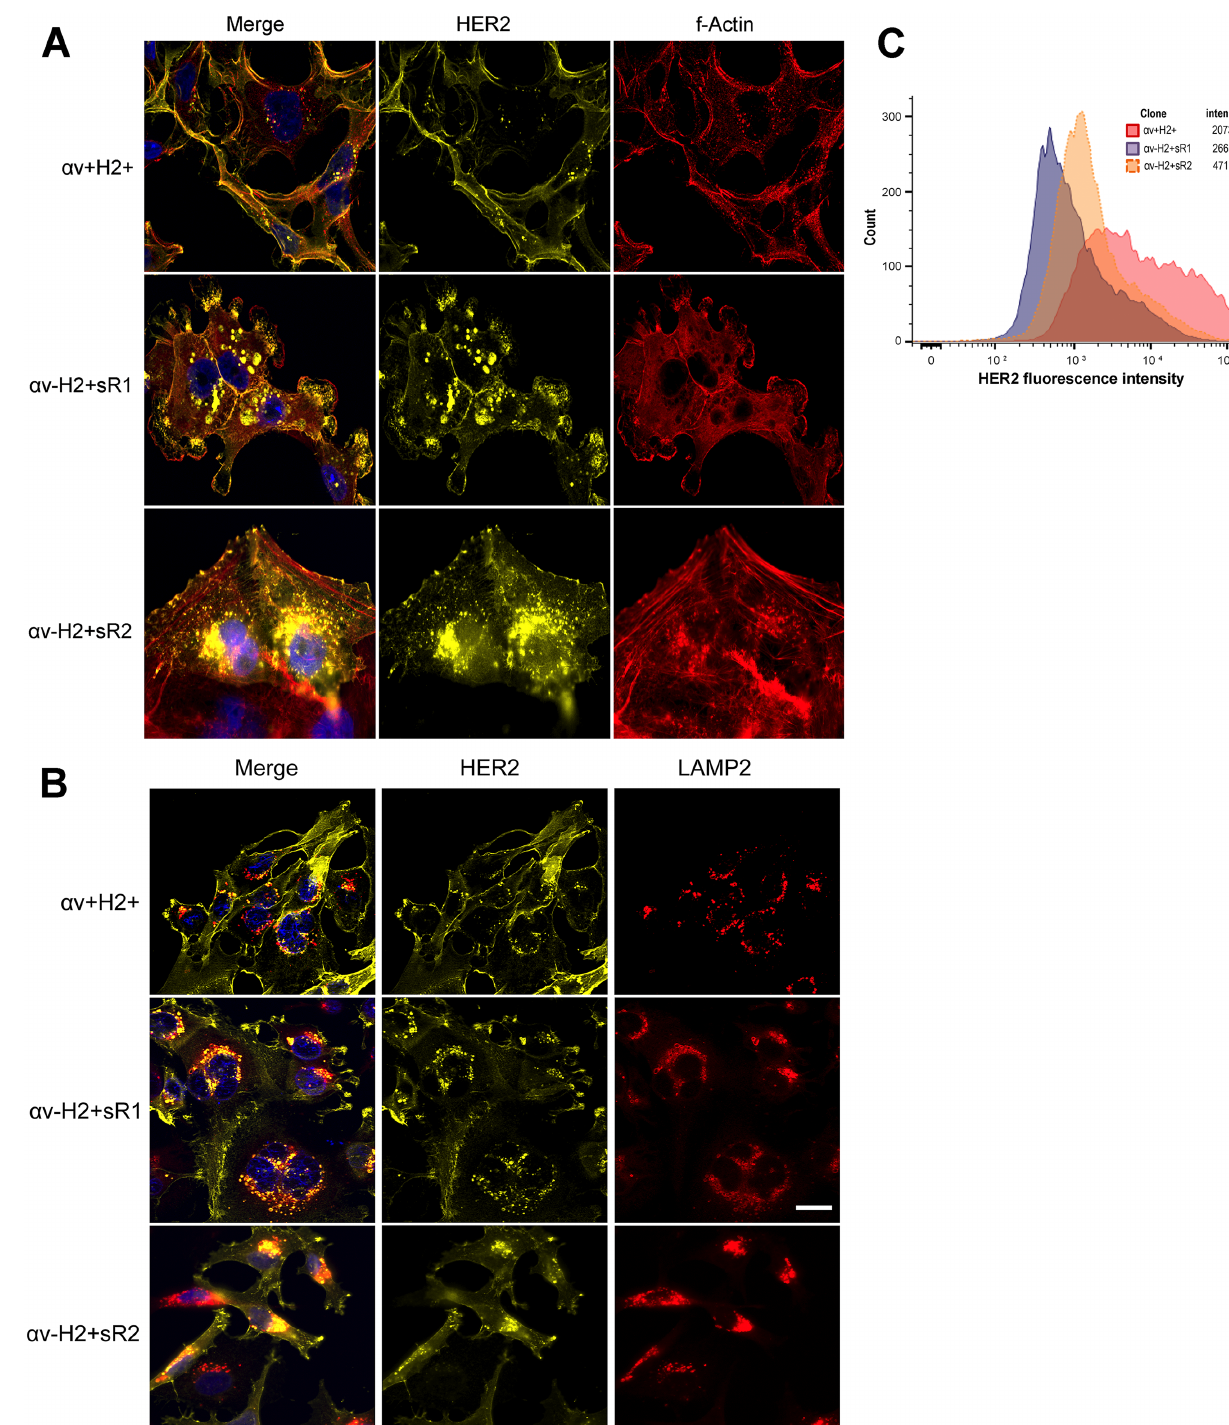
Fig 4. localization of HER2 in α v-integrin knockdown breast cancer cells. MM2BH cell clones grown on glass coverslips were fixed, permeabilized and immunostained. (A) Deficiency of α v-integrin results in increased cytoplasmic localization of HER2 receptors. Yellow: HER2, using an antibody specific for the HER2 intracellular domain, red: f-actin, blue: nucleus. (B) HER2 co-localizes with lysosomes in α v-integrin knockdown cells. Yellow: HER2, red: lysosome-associated membrane protein2 (LAMP2), blue: nucleus. The images are representative of three independent experiments. Scale bar = 20 μ m. (C) Flow cytometry analysis of surface HER2 protein expression in live MM2BH clones.